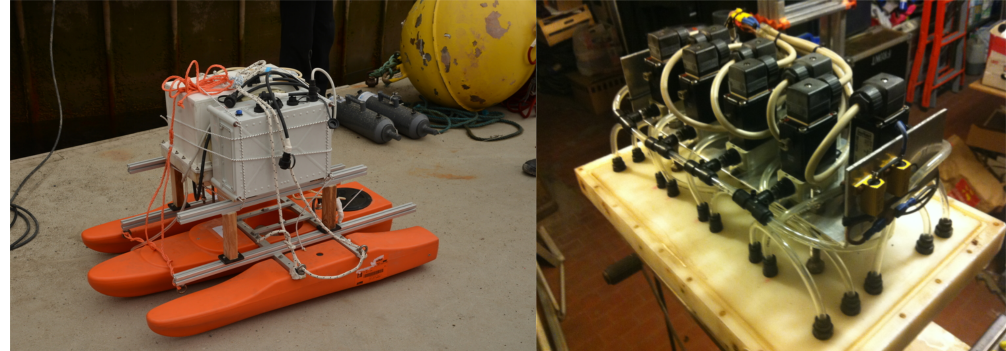
Figure 8. Towed trimaran equipped with an Autonomous Water Sampler